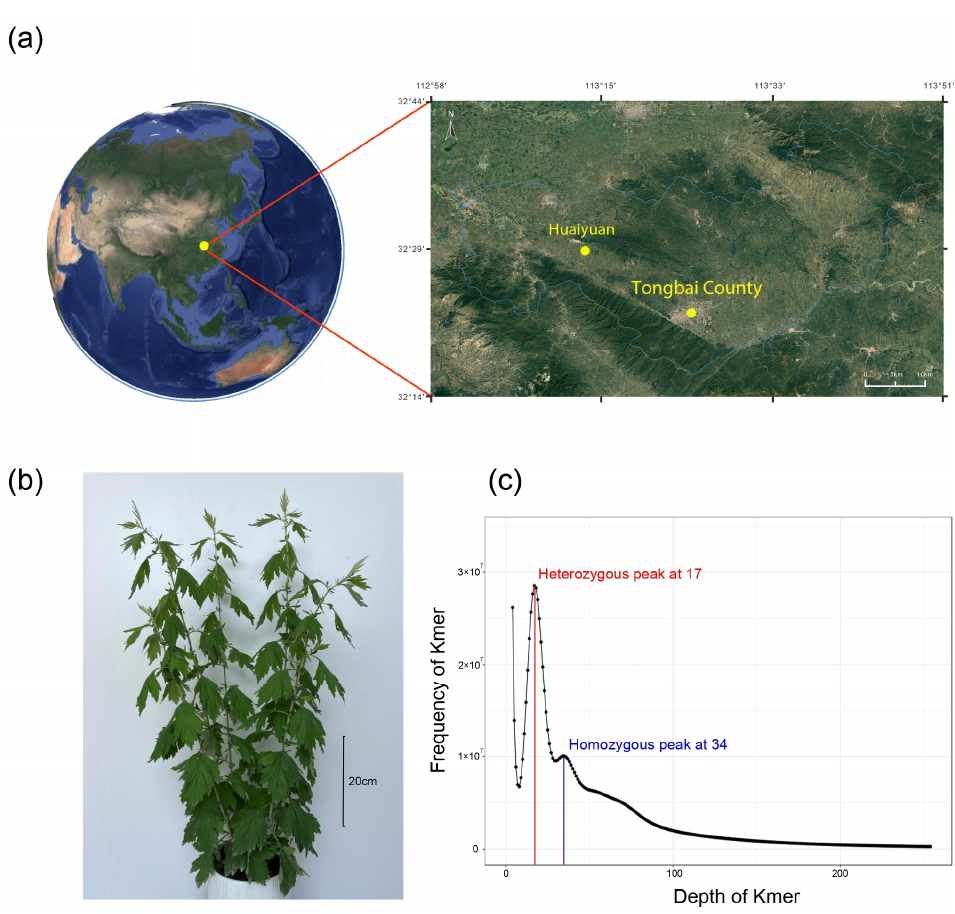
Figure 1. Location of the study site and genomic characteristic of the wild A. argyi . ( a ) Sampling site of ArteW1-Tongbai (Google Earth, earth.google.com/web/, accessed on 30 April 2020). ( b ) Picture of the ArteW1-Tongbai growing in “Protected Area of wild A. argyi ”. ( c ) Estimation of the genome size of ArteW1-Tongbaibased on k -mer analysis.